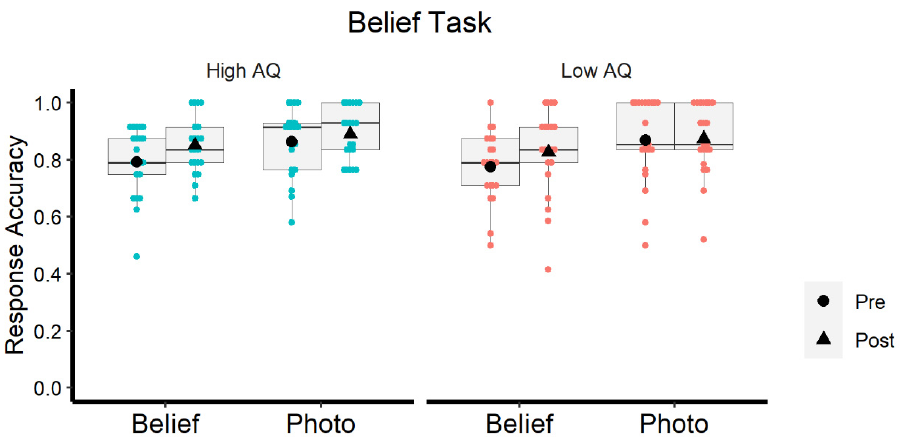
Figure 3. Probability of correct responses in the belief task, as a function of Group (high-AQ and low-AQ), Modality (false belief and false photo) and Test (pre- and post-test). As for the RTs, the high-AQ group showed a nonsignificant trend to respond more slowly than the low-AQ group (M = 4113 ms and M = 3903 ms, respectively; F (1, 40) =